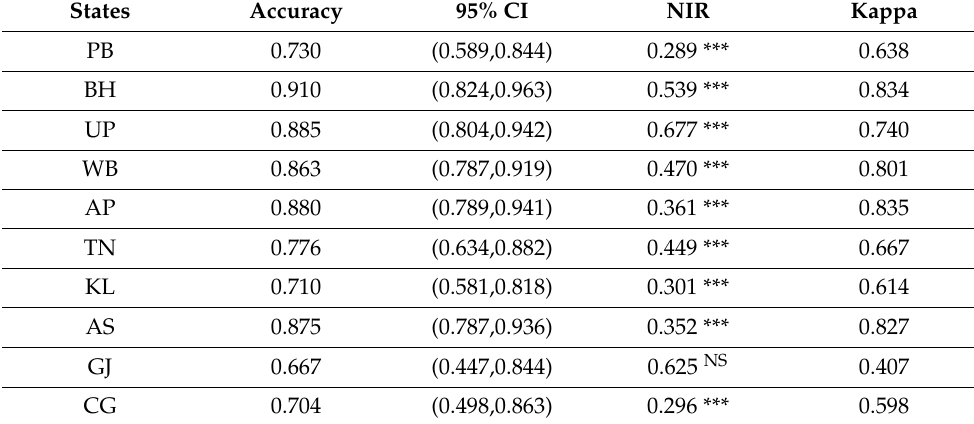
Table 9. Accuracy statistics of random forest models in the classification of the efficiency groups in paddy production across the major producing states of India in AY